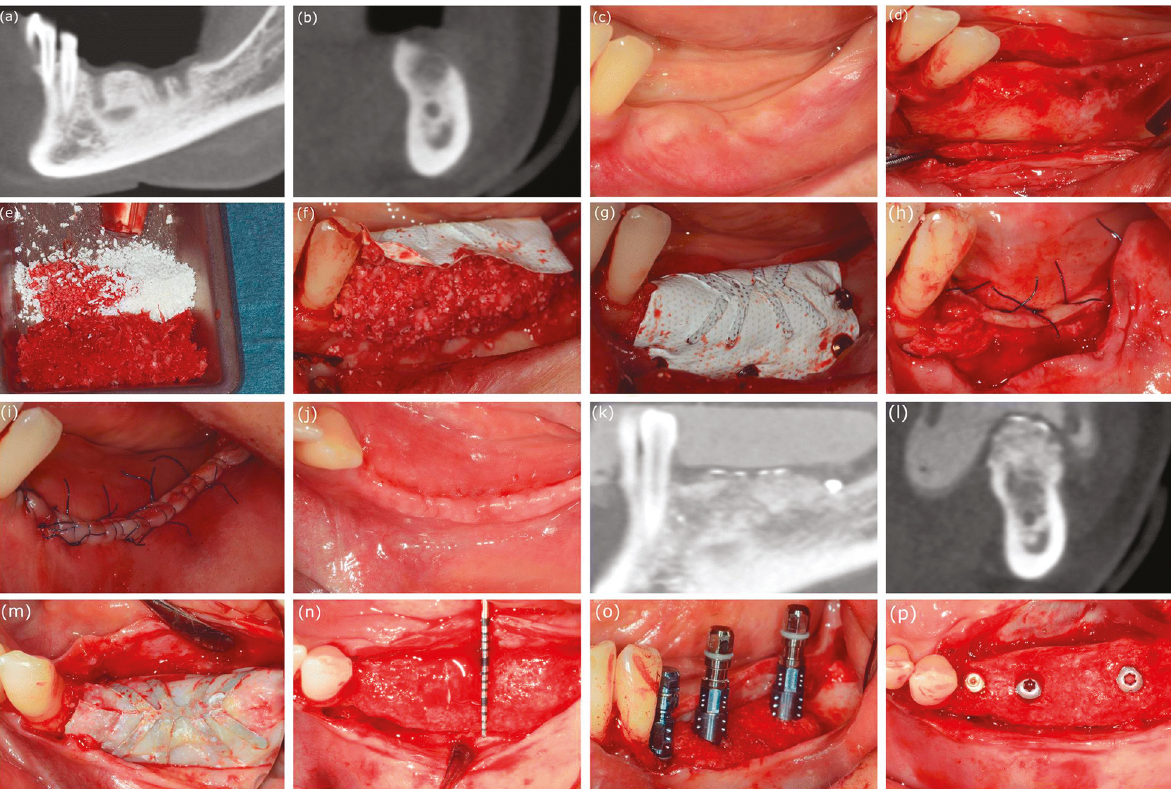
Figure 1: Bone augmentation with a titanium-reinforced d-PTFE membrane. (a) Primary CBCT scan, parasagittal section showing the horizontal and vertical bone defect. (b) Primary CBCT scan, frontal section showing the horizontal and vertical bone defect. (c) Clinical photograph of the edentulous mandible. (d) Flap preparation with the split-thickness method. (e) Bovine-derived xenograft (Geistlich Bio- Oss) and particulate autogenous bone graft. (f) Adaptation of nonresorbable titanium-reinforced d-PTFE membrane (Osteogenics Cytoplast) over the graft. (g) Fixing the membrane with titanium pins. (h) Suturing. (i) Closure of the mucosal layer with horizontal mattress and noninterrupted sutures. (j) Healing two weeks post-op. (k) Postoperative CBCT scan after nine months: parasagittal section. (l) Postoperative CBCTscan after nine months: frontal section. (m) Reentry for removing the membrane. (n) Good quantity of bone tissue for implant placement. (o) Guided implant surgery (Straumann bone level). (p) Final positioning of implants through a prosthetically driven technique